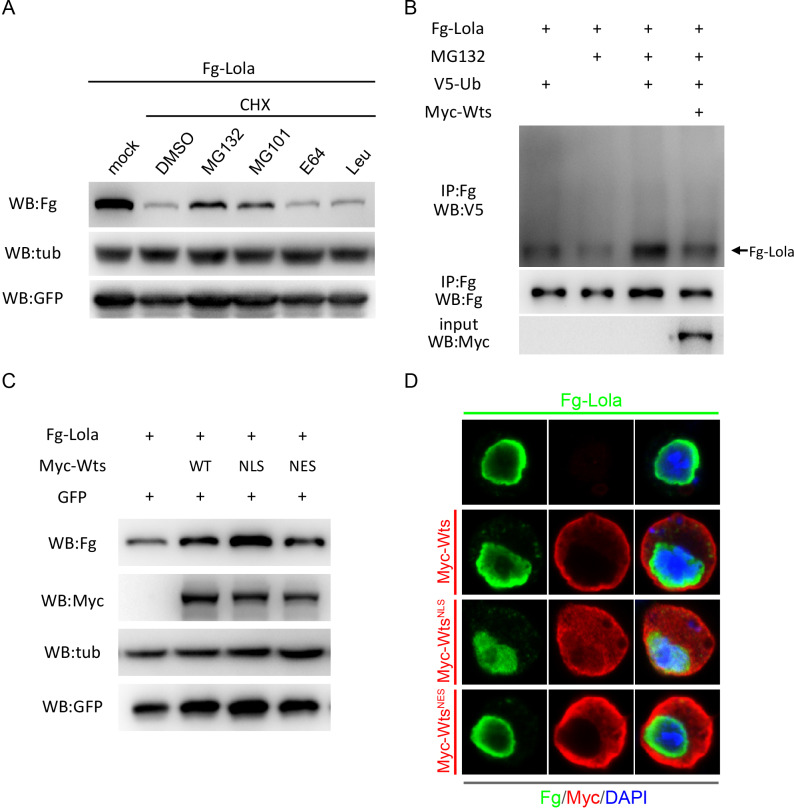
Wts affected Lola UPS-mediated degradation.(A) S2 cells were transfected with plasmids expressing Fg-Lola and treated with UPS inhibitors (MG132 and MG101) or lysosomal inhibitors (E64 and Leupeptin) for 3 hr followed by CHX treatment for an additional 6 hr. Cells were harvested and analyzed by Western blot with the indicated antibodies. Note that CHX-induced Lola degradation was rescued upon incubation with UPS inhibitors (MG132 and MG101), but not with DMSO or lysosomal inhibitors (E64 and Leu). (B) In vivo ubiquitination assay of Lola in S2 cells. Fg-Lola was immunoprecipitated from S2 cells expressing the indicated proteins and treated with MG132, followed by Western blot with V5 antibody to detect conjugated V5-Ub. (C) Collected cell extracts from S2 cells transfected with plasmids expressing Fg-Lola, and Myc-Wts, Myc-WtsNLS or Myc-WtsNES were analyzed by Western blot with the indicated antibodies. (D) Representative images of S2 cells transfected with plasmids expressing Fg-Lola, and Myc-Wts, Myc-WtsNLS or Myc-WtsNES immunostained with Fg (green), Myc (red), and DAPI (nuclei, blue).